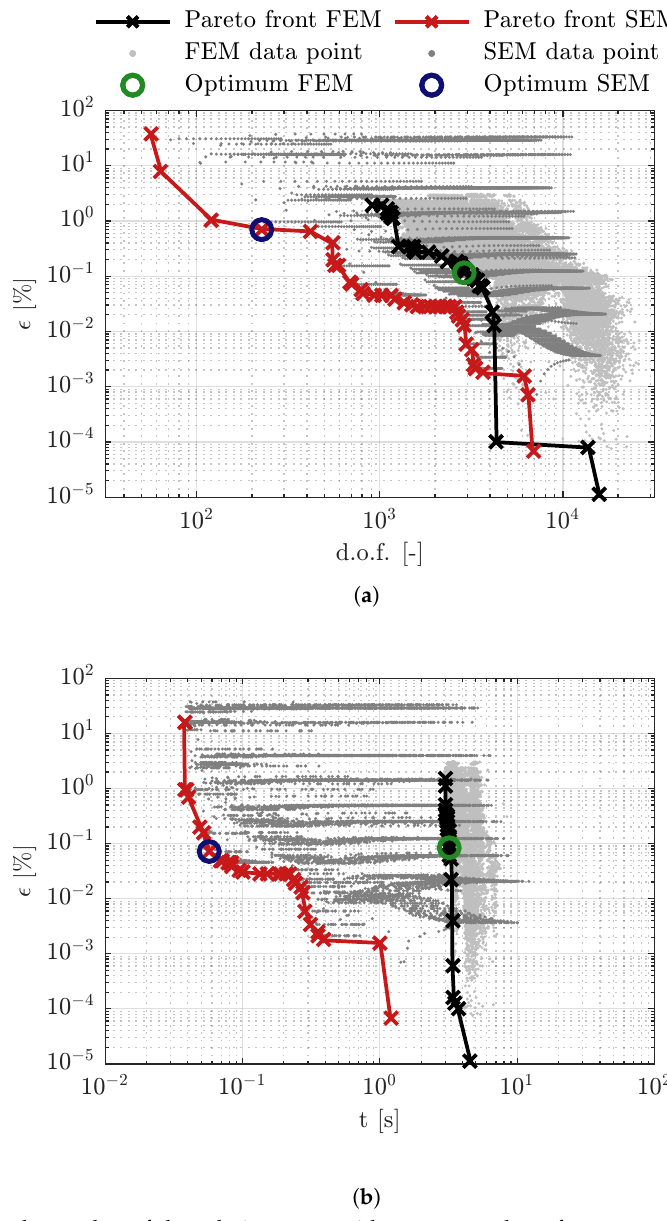
Figure 6. Absolute value of the relative error with respect to the reference as a function of ( a ) the number of d.o.f. and ( b ) the computation time. The Pareto fronts and optima ( w 1 = w 2 = 0.5 ) are indicated in both